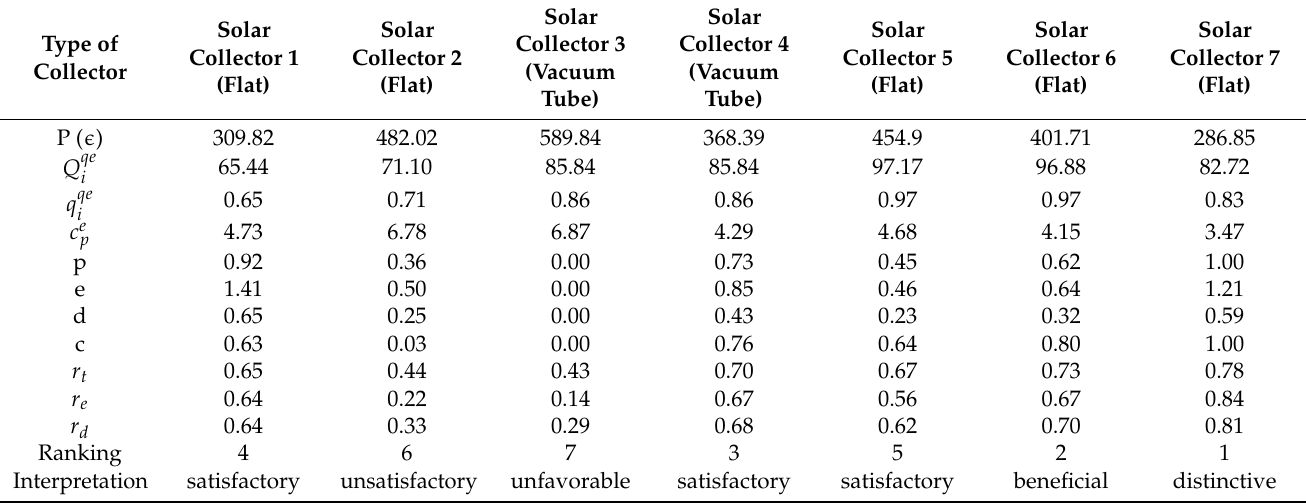
Table 5. Results of the proposed method considering only qualitative criteria of solar collectors.